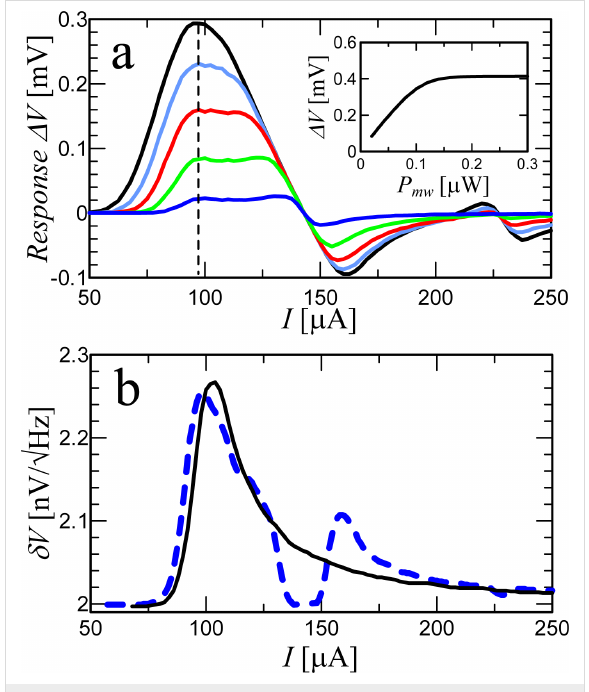
Figure 6: (a) Response Δ V versus dc current I for different MW signals, from bottom to top: P MW = 5, 20, 40, 60, and 80 nW. The dotted line represents the optimal detection regime for the bias current I = 98 μ A. The inset shows the dependence of the response at the operating point on the magnitude of the external signal. (b) Total output voltage noise of the Josephson junction versus bias current for P MW = 0 W (solid curve) and P MW = 10 nW (dashed